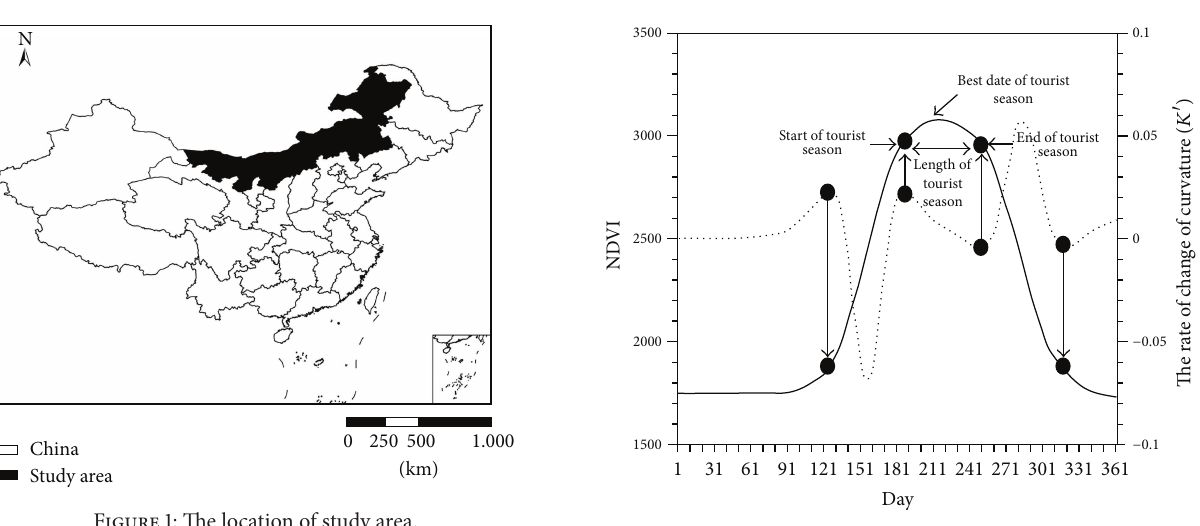
Figure 1: The location of study area.